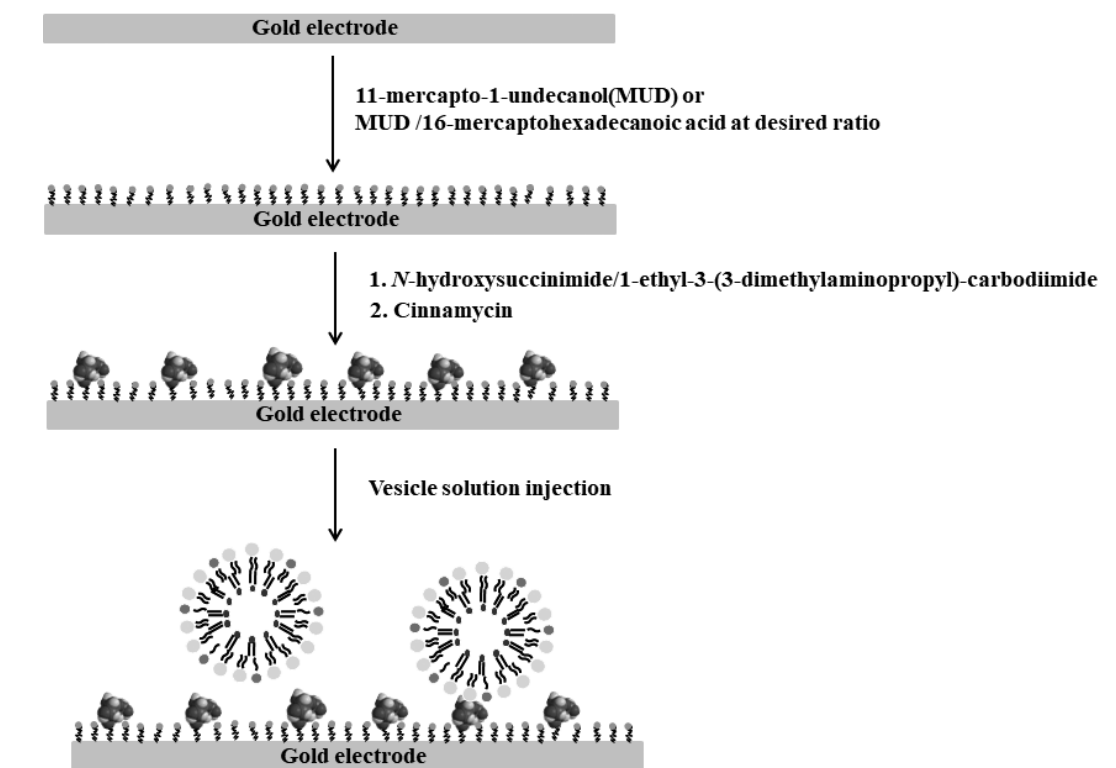
Figure 1. Surface treatment procedure on the gold electrode for CV experiments.